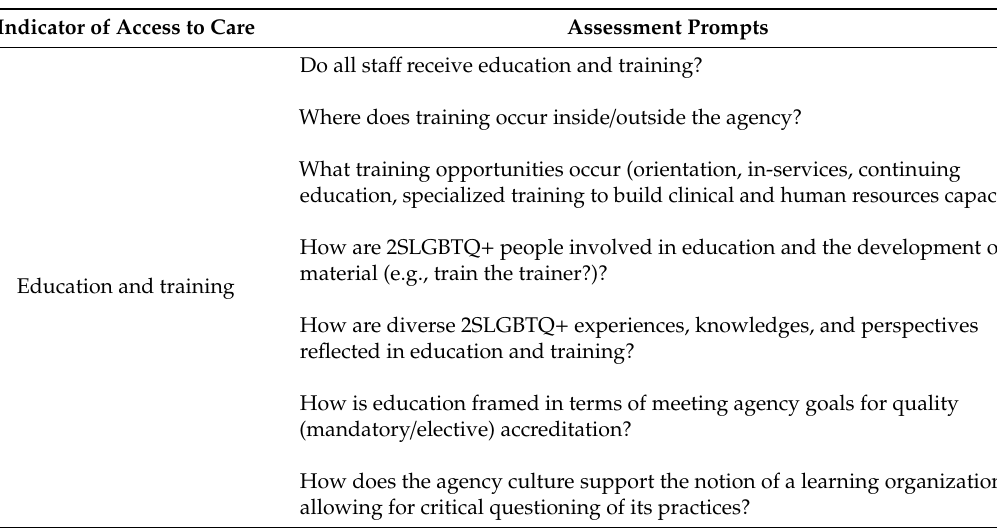
Table 3. Assessing home care provider 2SLGBTQ + knowledge.